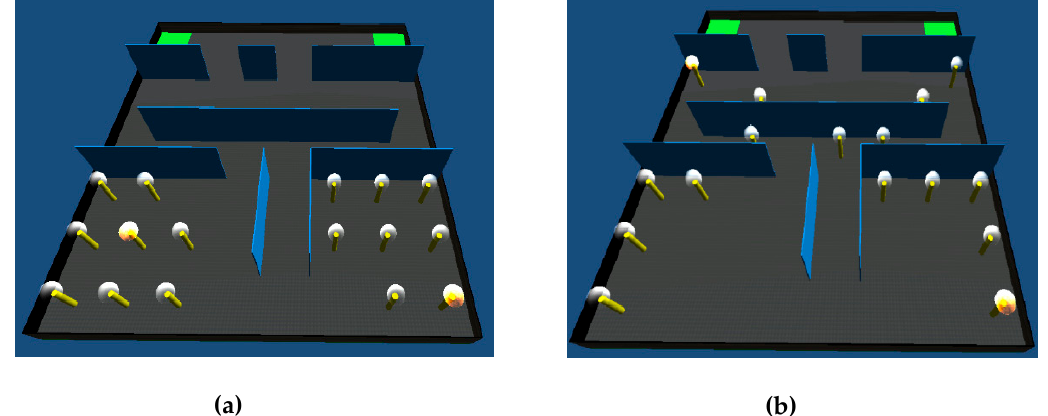
Figure 8. Office layout and starting points of agents (black: border; blue: walls; green: exit/goal): ( a ) case 1: worst-case layout of agents; ( b ) case 2: homogeneously distributed agents (normal